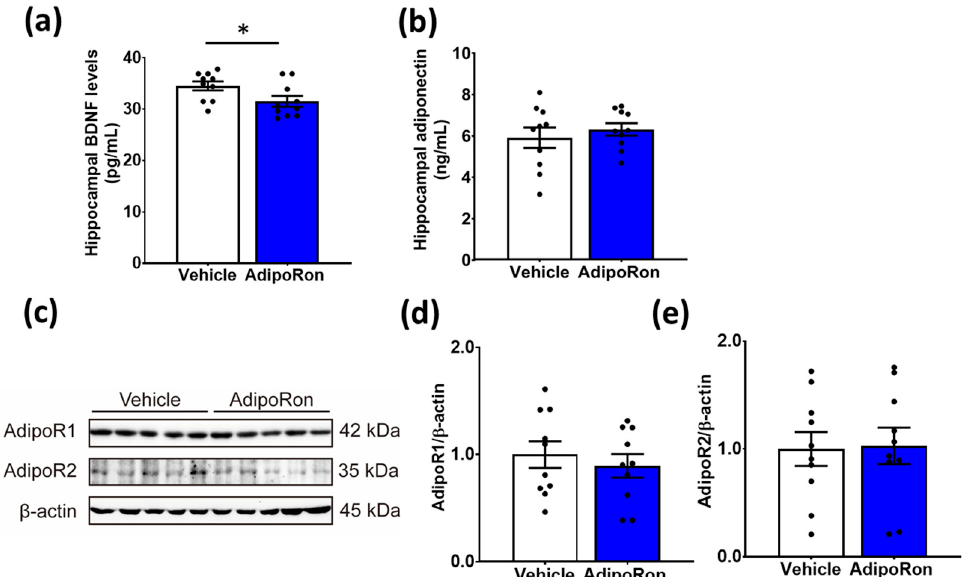
Figure 5. Sub-chronic AdipoRon treatment reduced protein levels of brain-derived neurotrophic factor in the hippocampus. ( a ) Seven-day AdipoRon treatment significantly reduced hippocampal BDNF levels, although changes in the level of ( b ) hippocampal adiponectin. ( c ) Protein expression of ( d ) hippocampal AdipoR1 or ( e ) AdipoR2 was not significantly affected. Student t -test, * p < 0.05. Data presented as mean ± SEM.